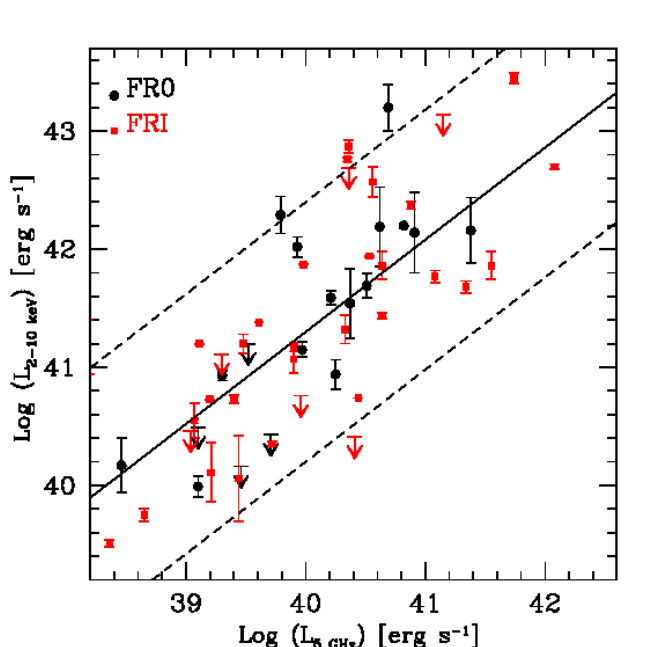
Figure 3. X-ray (2–10 keV) luminosity versus radio core (5 GHz) luminosity (in erg s − 1 ) for FR 0s (black circles) and FR Is (red squares). Upper limits are represented by arrows. The black solid line is the linear regression for FR 0s + FR Is: log L X = (7.8 ± 0.6) + (0.8 ± 0.1)log L 5 GHz . Black dashed lines are uncertainties on the slope, taken from